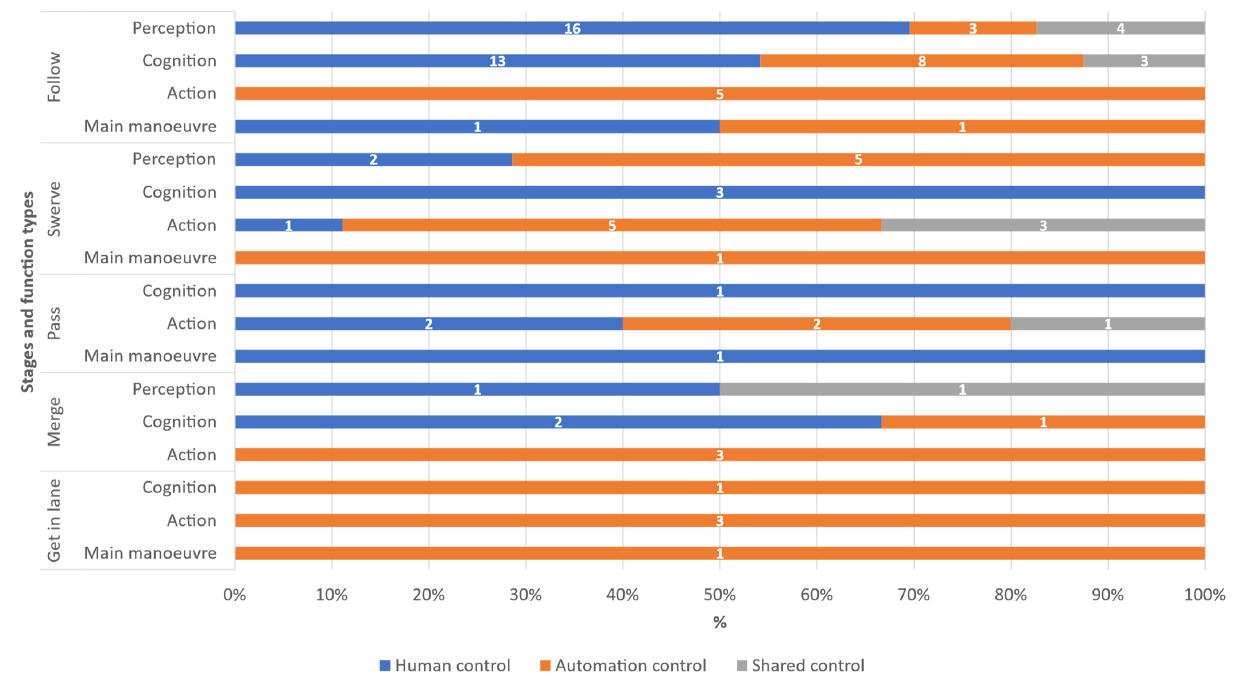
Figure 15. Function allocation between human driver and automation.